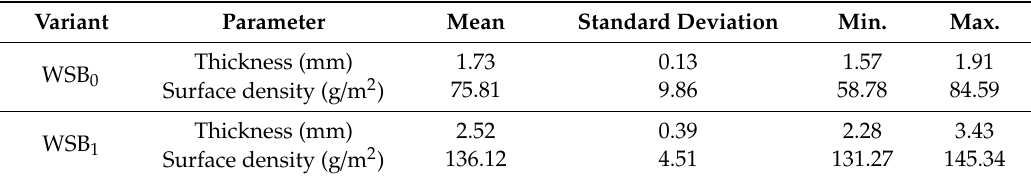
Table 2. Characteristics of the produced multifunctional polymeric composite and the reference nonwoven. Variant